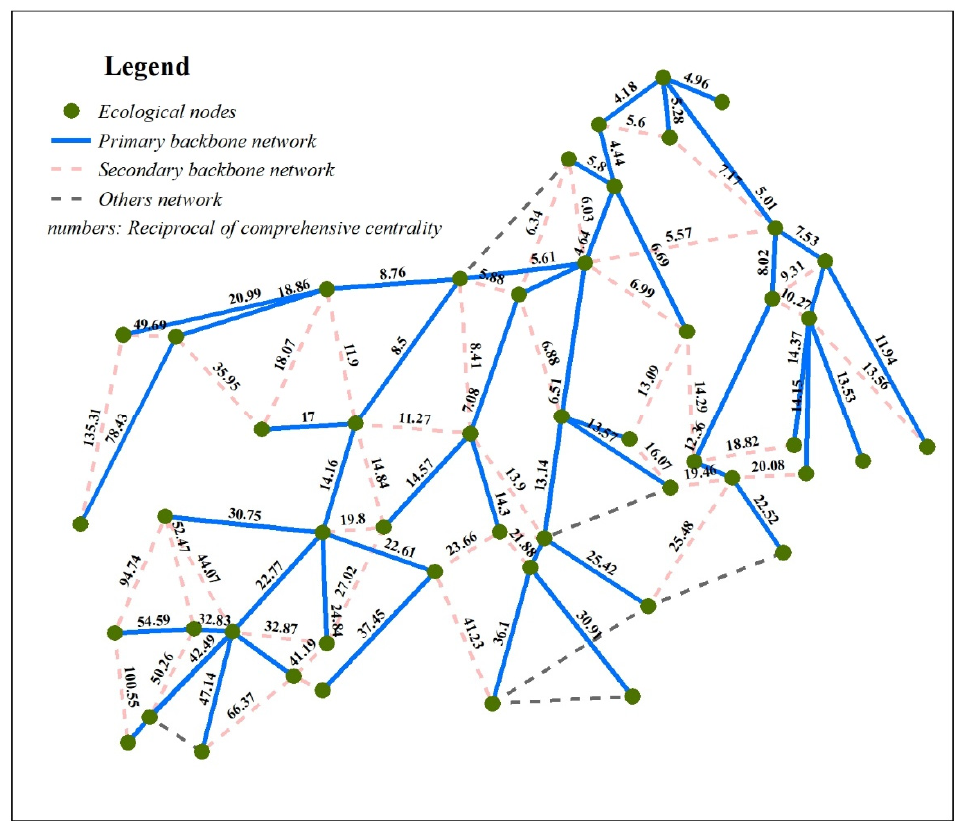
Figure 4. Schematic diagram of backbone structure for ENs.